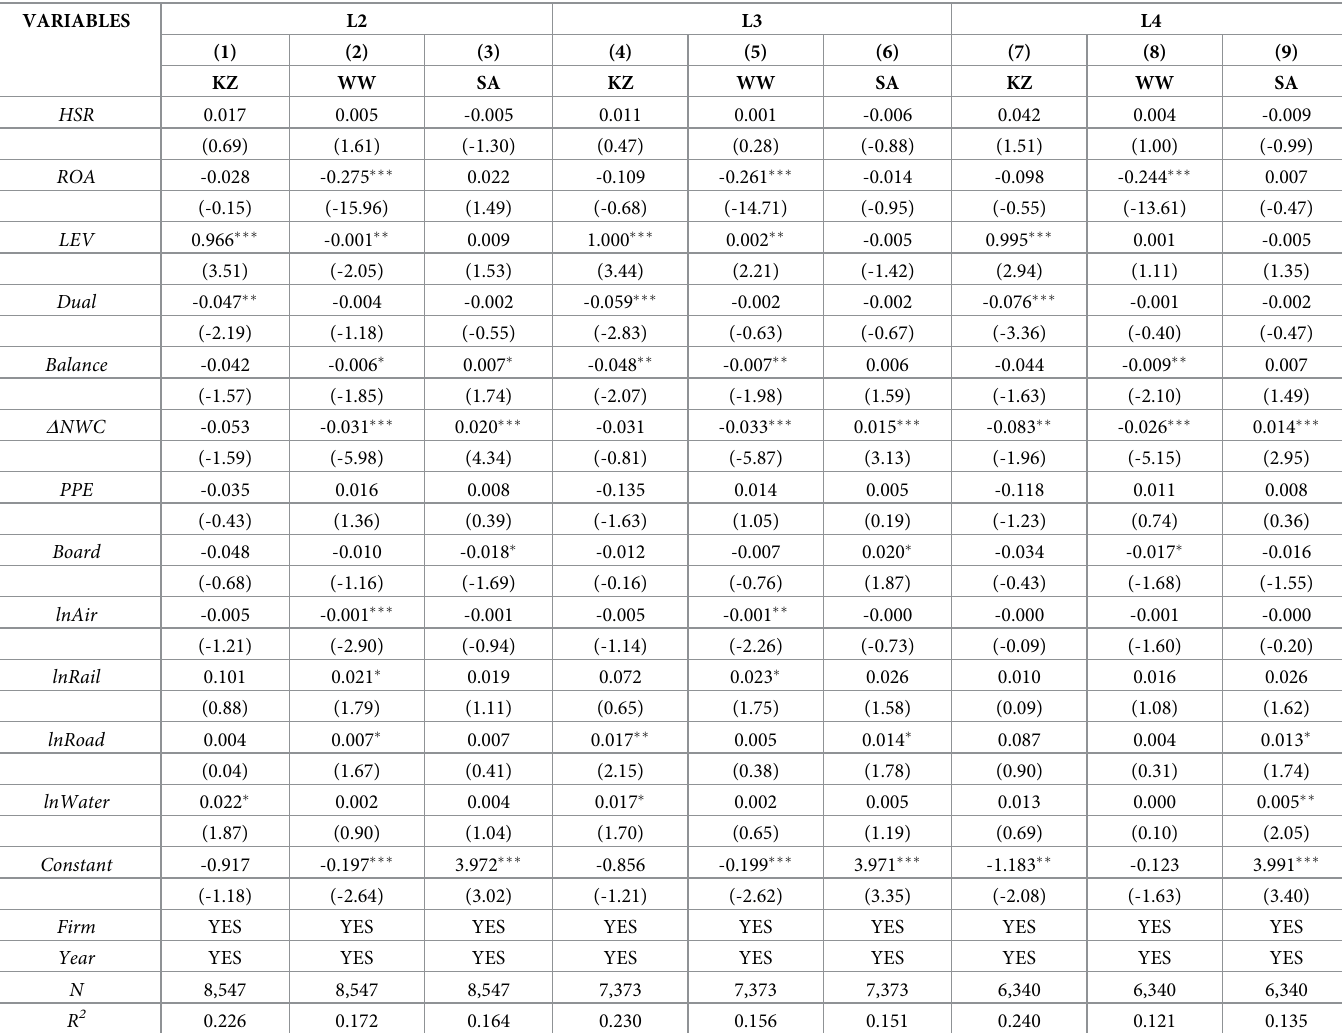
Table 8. Placebo test